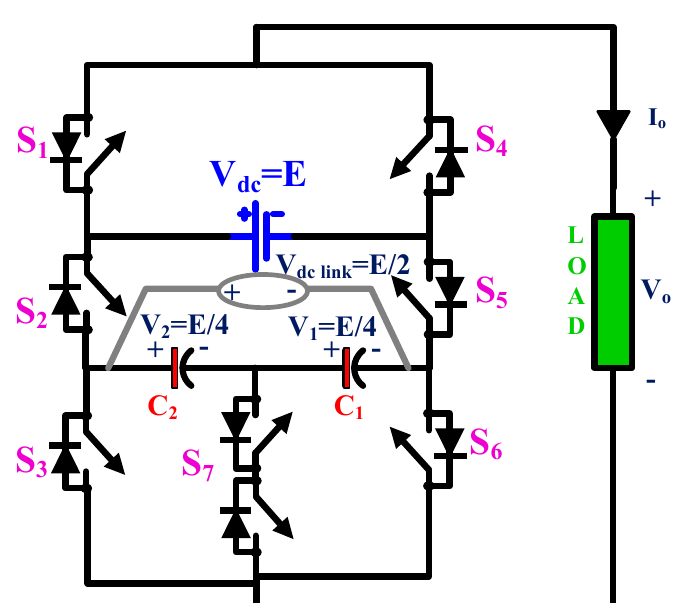
Figure 2. Existing configuration of nine-level MLI [32]. Table 1. Switching States of the nine-level PEC9 MLI.